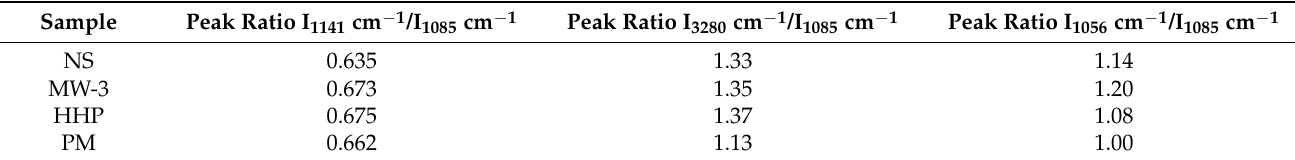
Figure 3. FTIR-ATR spectra of the non-sterile and sterile PVA/PBO hydrogels, in the region of 4000–400 cm − 1 . Table 1. Peak intensity ratios of relevant peaks from Figure